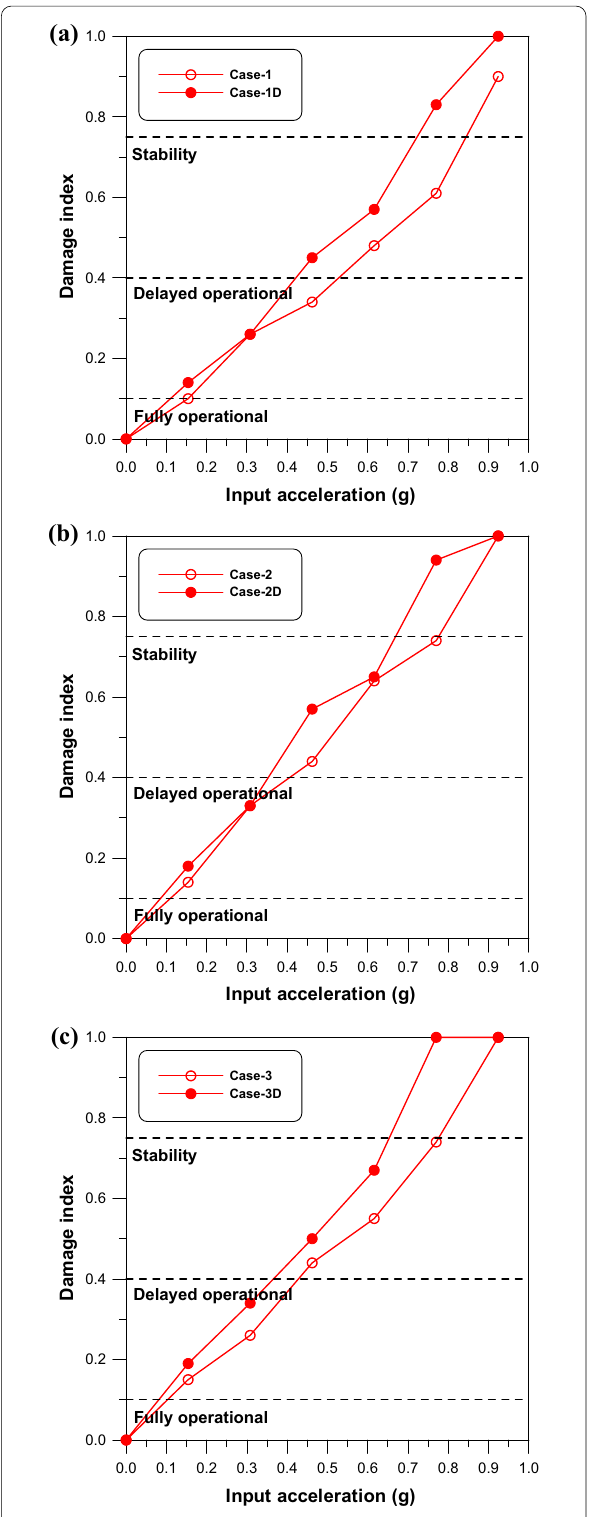
Fig. 16 Assessment of seismic performance level for cases: a Case‑1 and Case‑1D, b Case‑2 and Case‑2D and (c) Case‑3 and